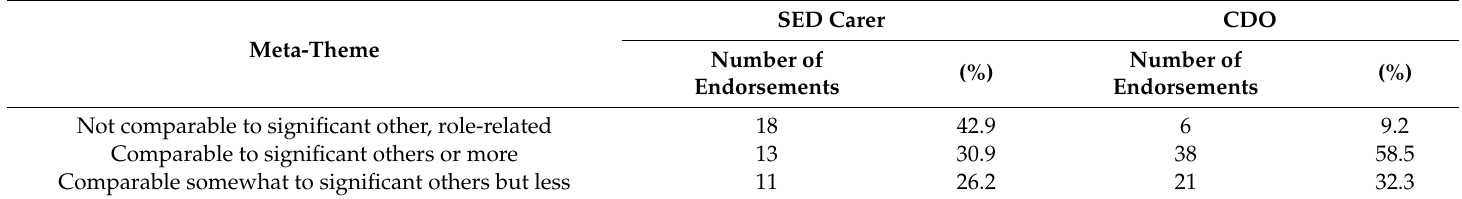
Table 10. SED and CDO meta theme endorsement for feelings towards their dogs as compared to significant